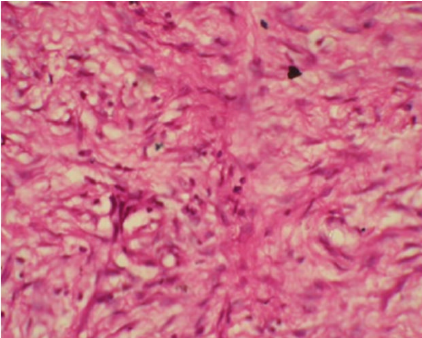
Figure 5: Photomicrograph showing fibrous connective tissue consisting of plump, spindle shaped fibroblasts.